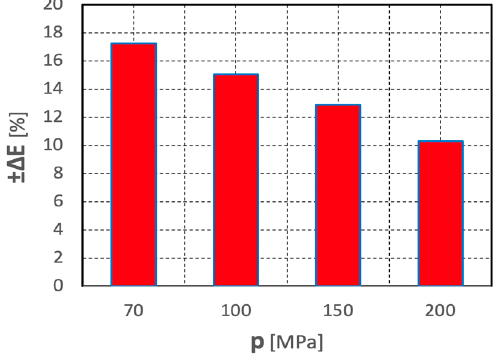
Figure 20. Effect of water jet pressure on the spread of relative values of unit energy inputs during the comminution of polymetallic concretions in a hydro-jet mill (for d w = 0.7 mm, d h = 2.4 mm, s = 10 mm).